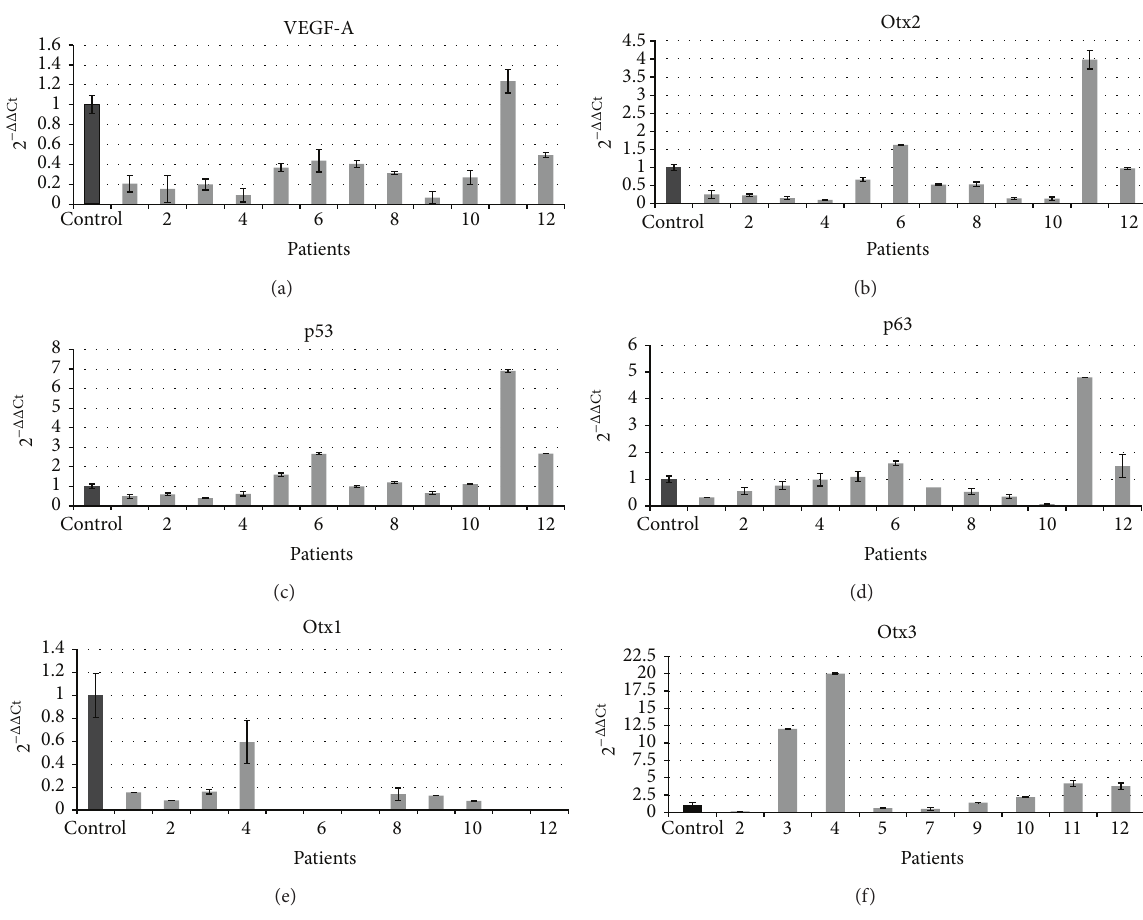
Figure 3: Gene expression levels in adult healthy human samples and in patients affected by PVR. Gene levels were detected by quantitative PCR. 2 −ΔΔ Ct values representing gene expression are shown on 𝑦 -axis. Black column: adult human samples as controls; gray columns: PVR affected patients. VEGF-A, Otx2, p53, and p63 show the similar expression trend, inversely to Otx1 and